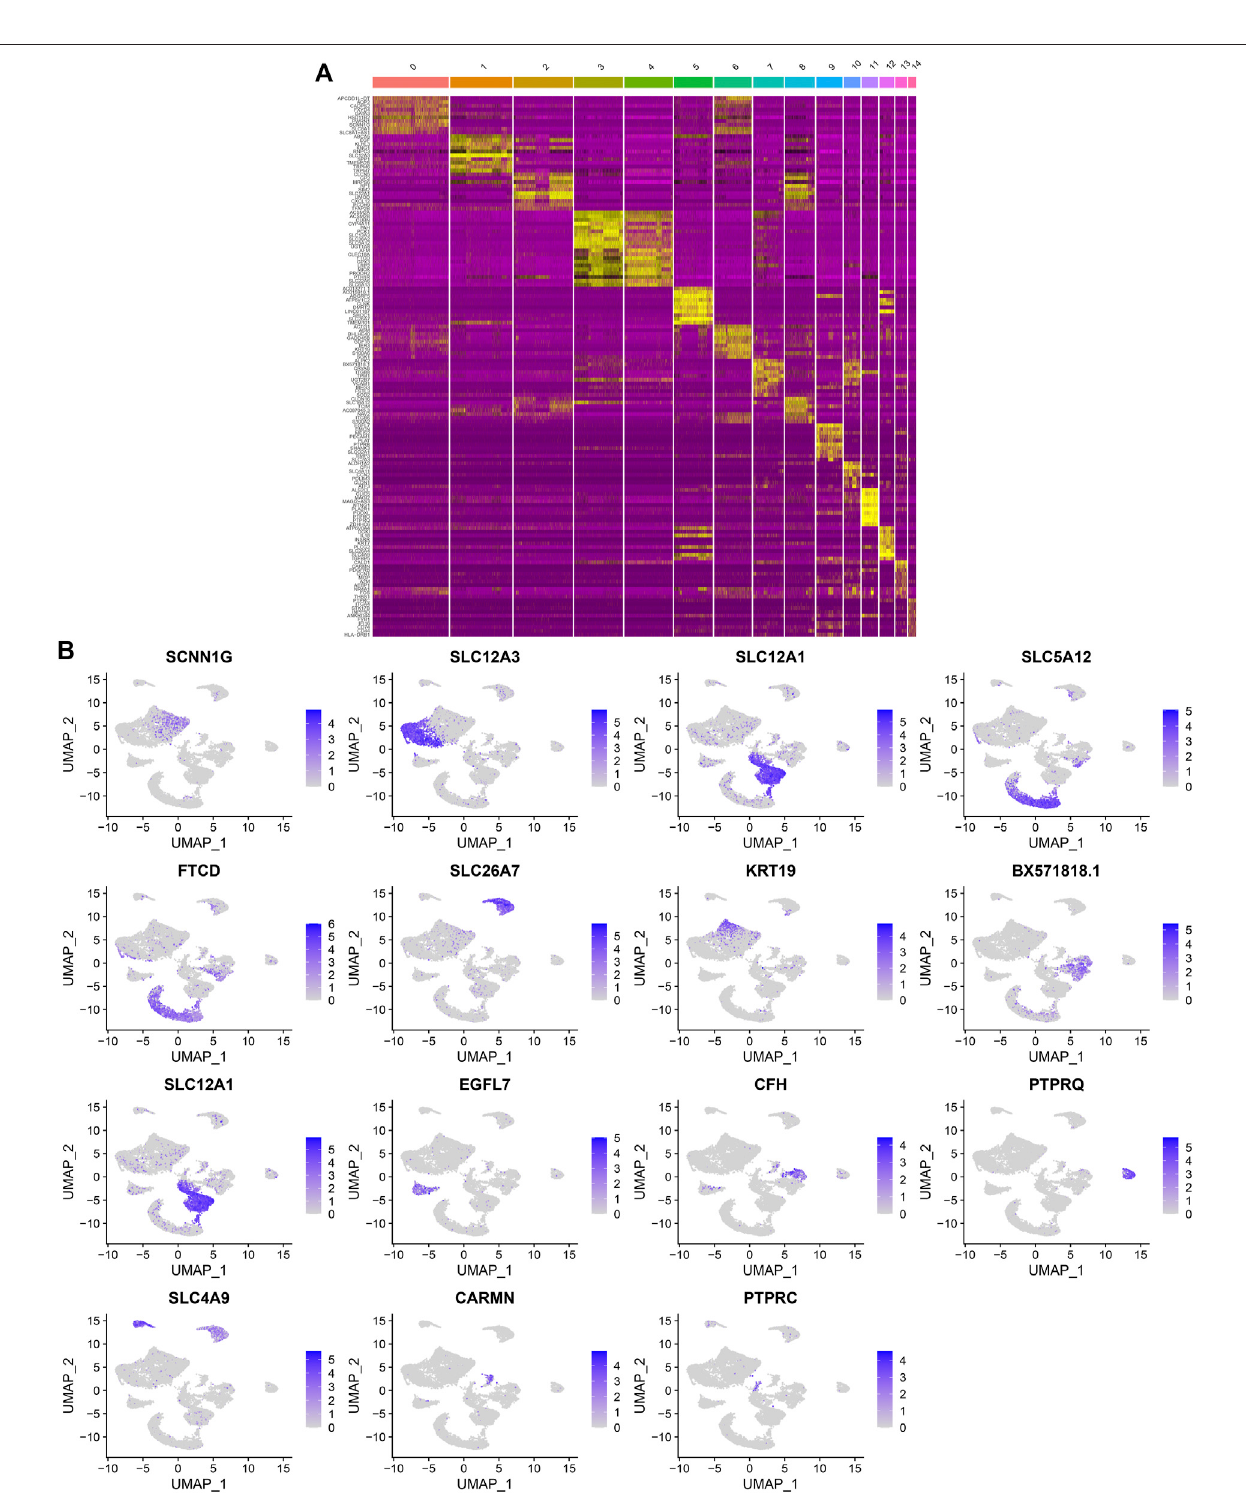
FIGURE 4 | Identi fi cation of marker genes in each cell cluster. (A) Heat map showing the top ten marker genes in each cell cluster. Yellow represented high expression. (B) The expression distribution of the top one marker gene (SCNN1G, SLC12A3, SLC12A1, SLC5A12, FTCD, SLC26A7, KRT19, BX571818.1, EGFL7, CFH, PTPRQ, SLC4A9, CARMN, and PTPRC) in each cell cluster.